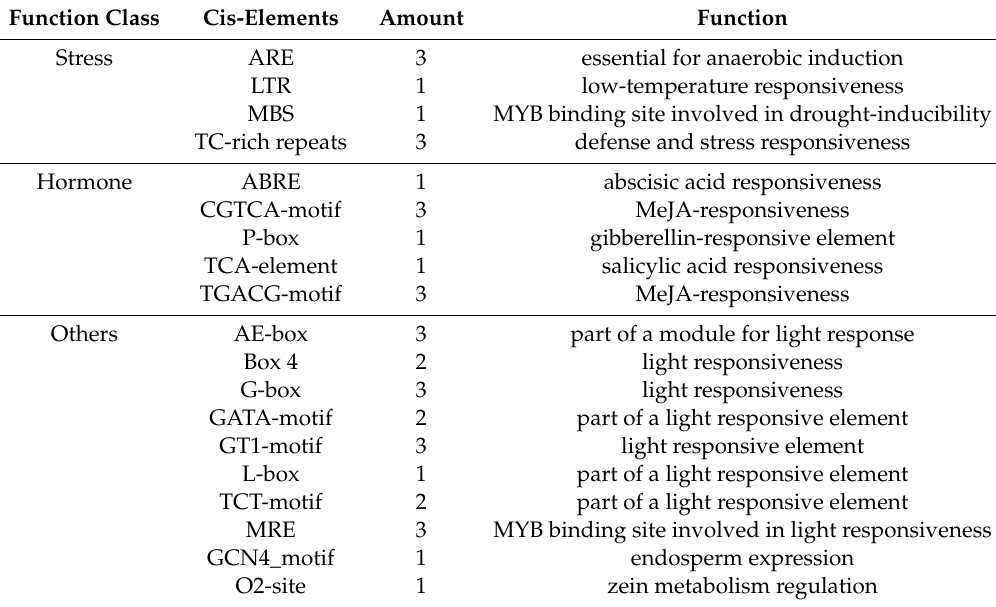
Table 2. The cis-acting regulatory element in the promoter of FvSnRK1.1.